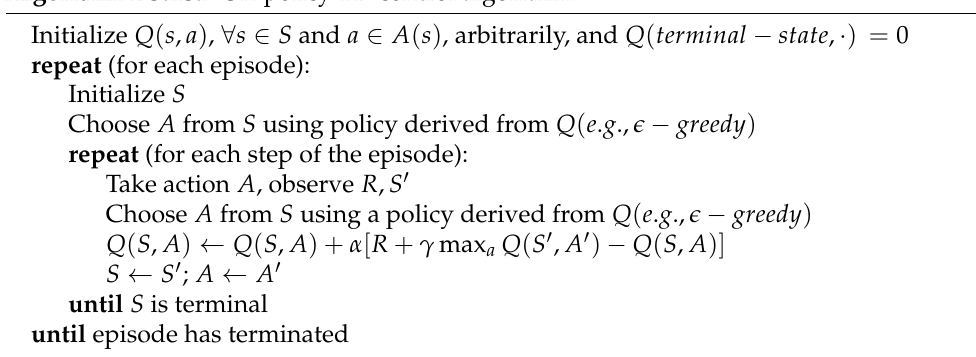
Algorithm 2 Sarsa: On-policy TD control algorithm.